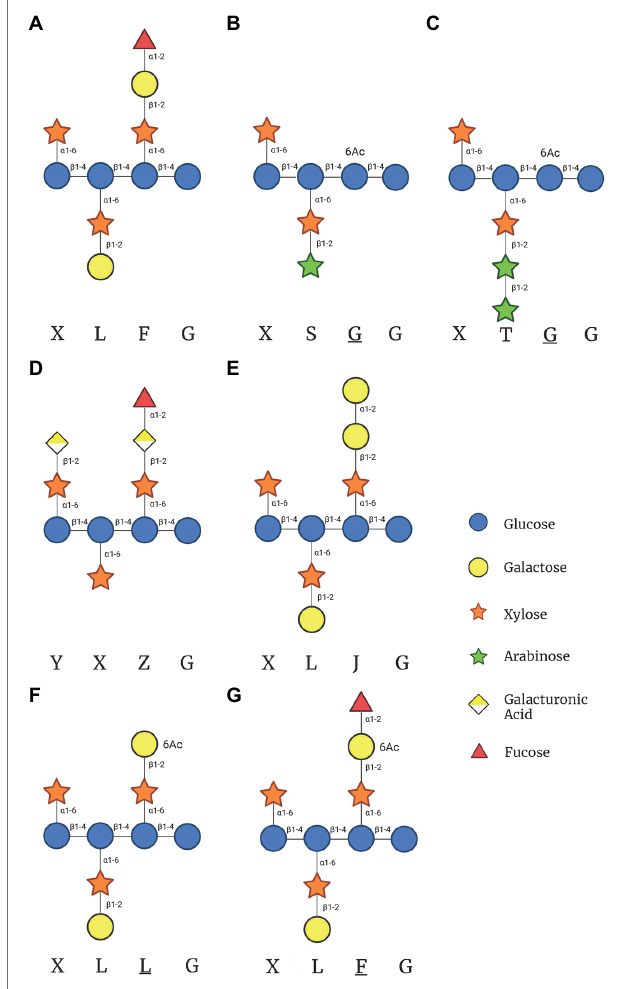
FIGURE 1 | Xyloglucan (XyG) subunits mentioned in this review found within hemicellulose extracts of plant cells walls. (A) The common XyG subunit XLFG found in Arabidopsis cell walls. (B) XyG subunit found in XXGG type XyG from plants such as tomato and rice. (C) Diarabinosylated XyG subunit in XXGG type xyloglucan of tomato. (D) Fully branched XyG subunit found in Arabidopsis root hairs. (E) XyG subunit synthesized in the absence of GDP- Fuc in mur1 mutant plants. (F) Gal-6- O -acetylated XXXG type XyG after the hypothetical removal of fucose by Axy8. (G) Fucosylated XXXG XyG subunit with Gal-6- O- acetylation. This figure was created with